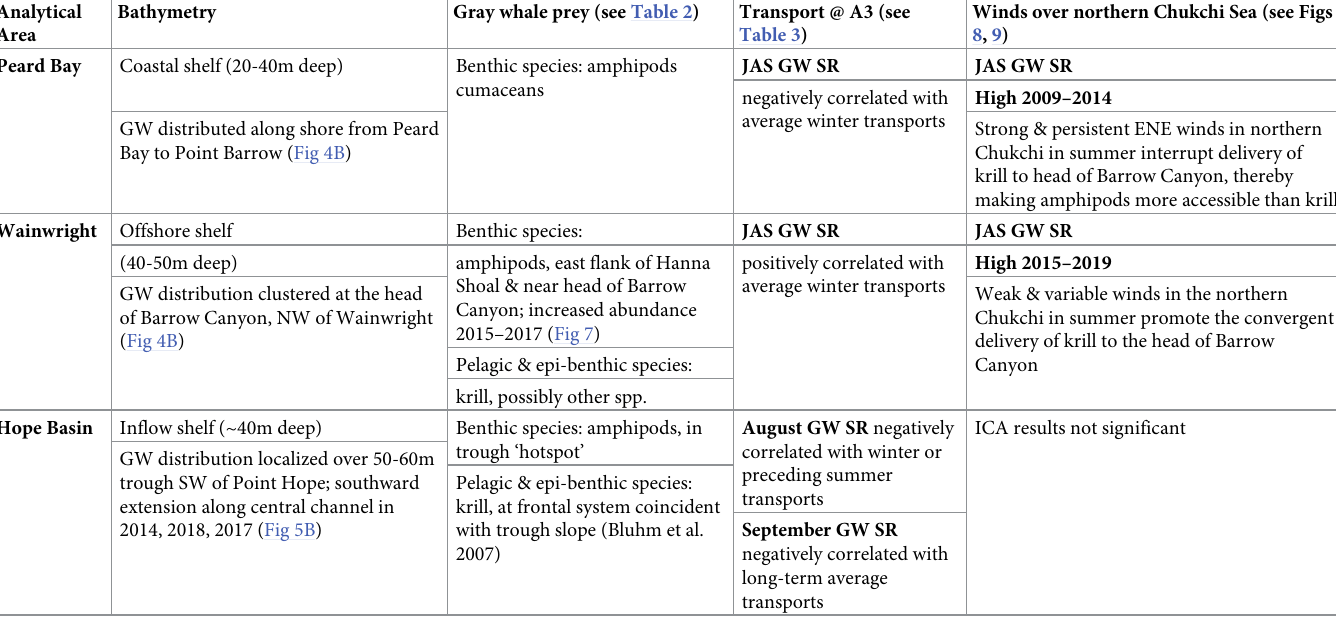
Table 4. Summary of bathymetry, gray whale prey and circulation drivers (transport and winds) used in iterative correlation analyses with Gray Whale (GW) Sight- ing Rates (SR) for three analytical areas in the northeastern Chukchi Sea. Analytical